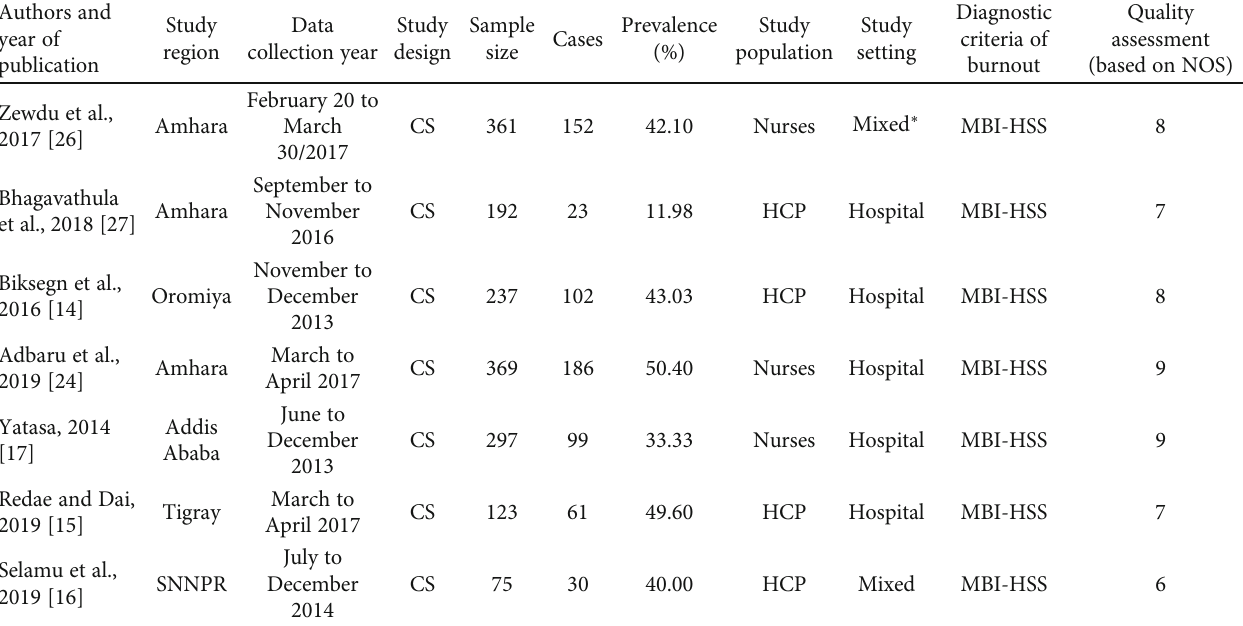
Table 2: Characteristics of studies included in the systematic review and meta-analysis of the prevalence of burnout among nurses in Ethiopia.